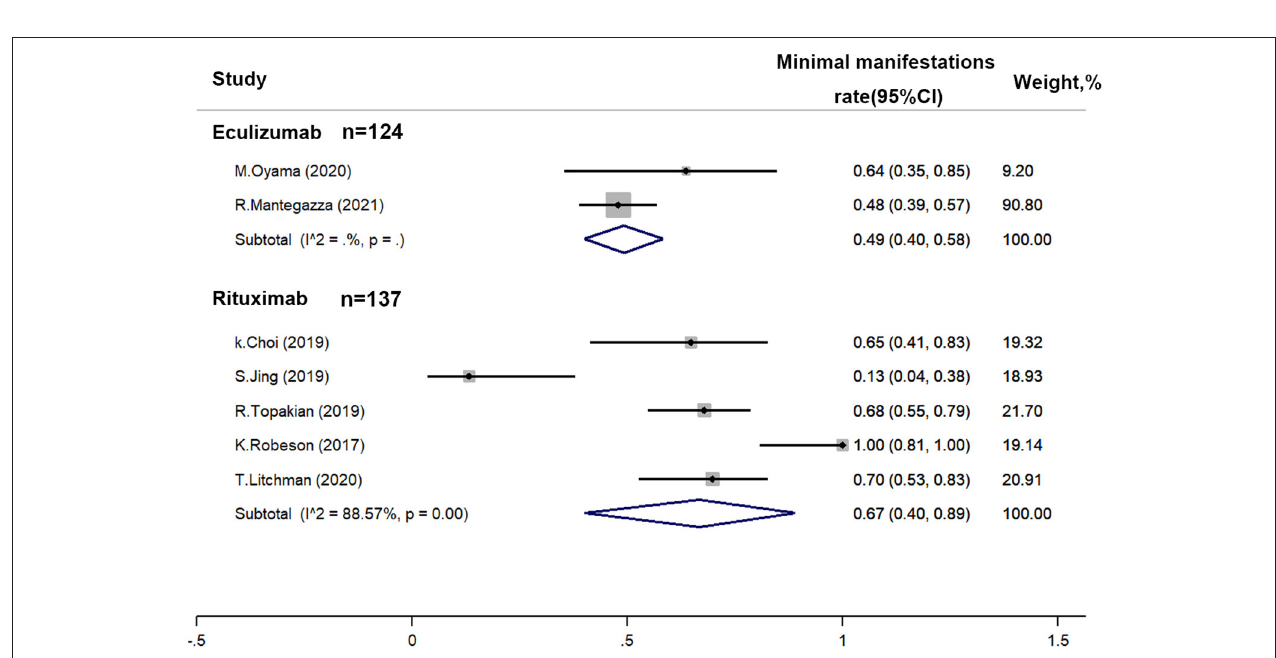
FIGURE 2 | Efficacy of immunotherapies in refractory myasthenia gravis (MG) based on quantitative myasthenia gravis score (QMG). (A) Quantitative synthesis of QMG reduction of rituximab, eculizumab, and tacrolimus. (B) Quantitative synthesis of severity index reduction based on QMG of rituximab, eculizumab, tacrolimus, and cladribine [Myasthenia Gravis Composite scale was used for studies of Levine ( 27) and Rejdak et al. (20). Manual muscle test was used for the study of Anderson et al. (28)]. A random-effect model was used for quantitative synthesis. Note that each therapy relieved the symptom of refractory myasthenia gravis (MG). However, no significant difference in therapeutic efficacy among these therapies. SMD stands for the standard mean difference.